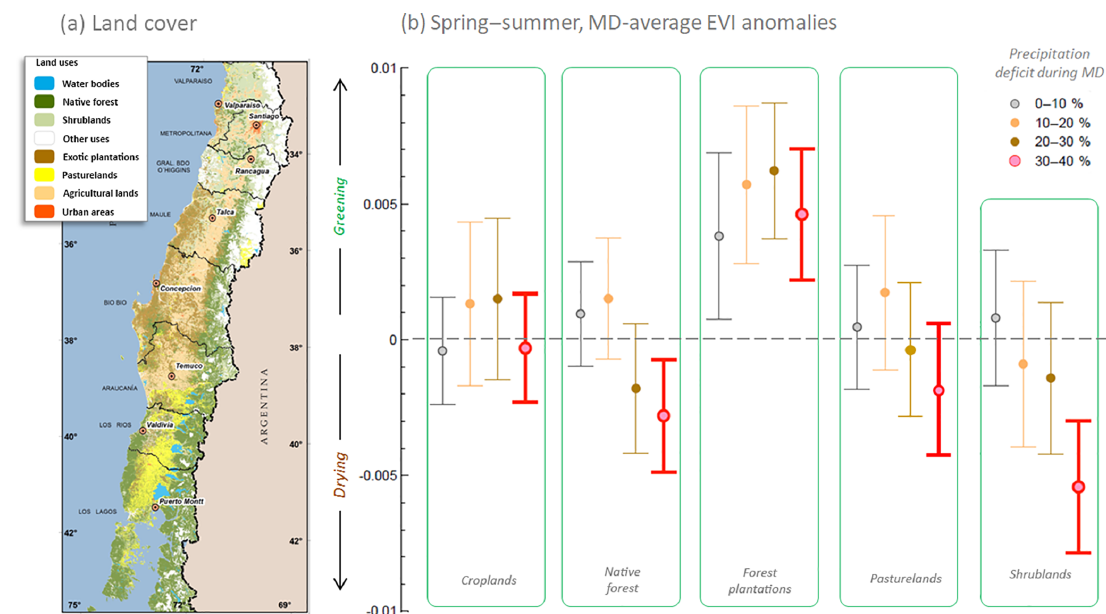
Figure 13. (a) Land cover (LC) classes for 2014 over central Chile. (b) EVI changes during the MD period (2010–2015) with respect to the previous decade (2001–2009) stratified according to the LC and the rainfall deficit during the MD. There are many 5 × 5km 2 pixels for each LC and rainfall deficit category: the circles indicate the median change, and the error bars are the ± 1 standard